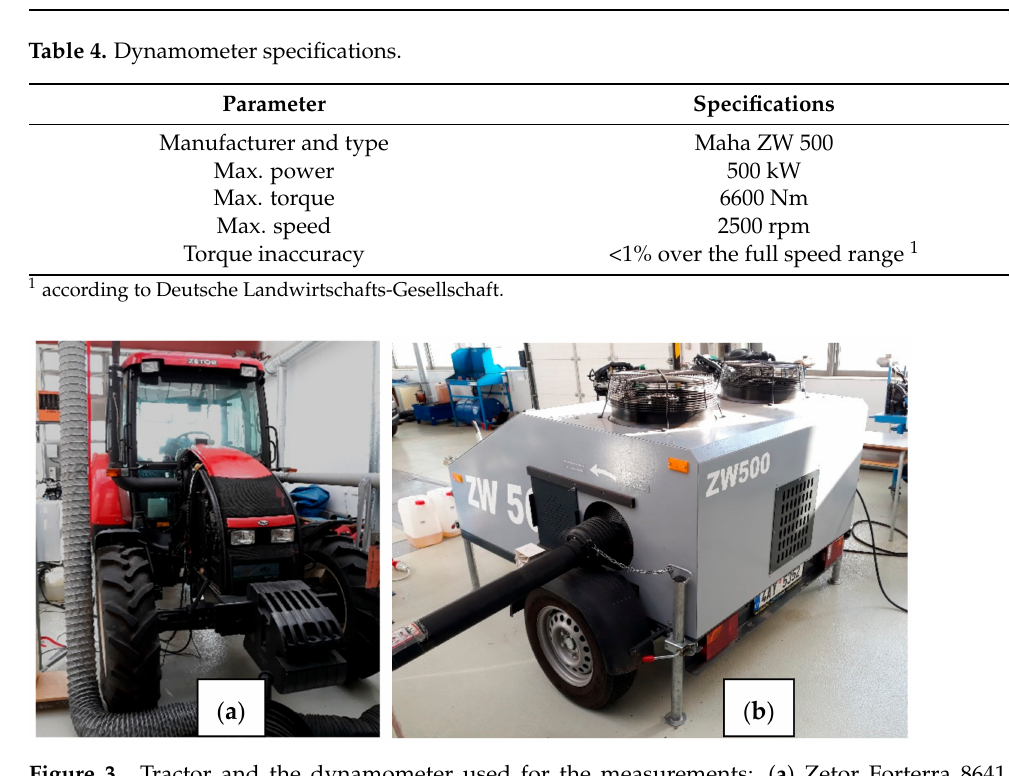
Figure 3. Tractor and the dynamometer used for the measurements: ( a ) Zetor Forterra 8641, ( b ) MAHA